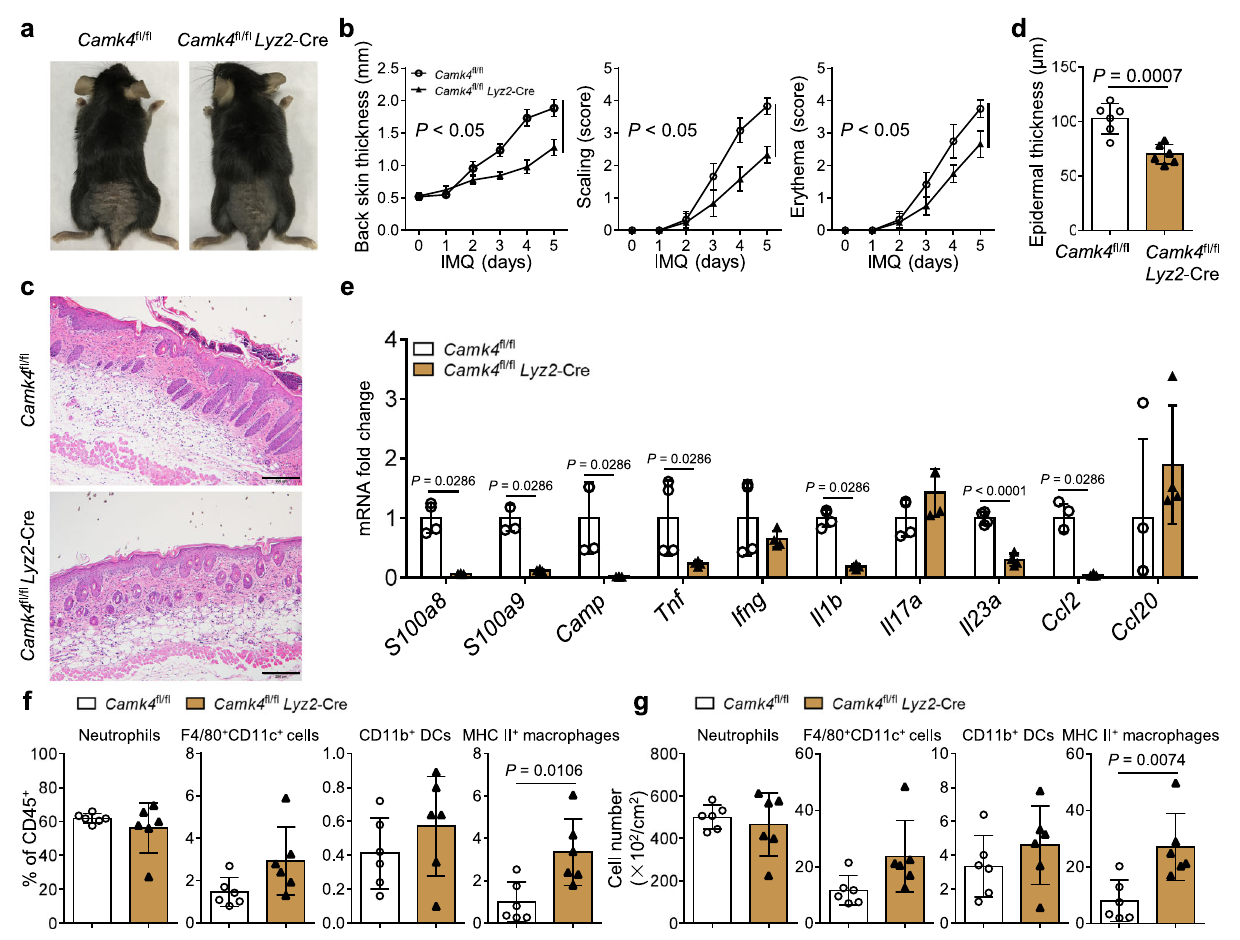
Fig. 7 | Loss of Camk4 in macrophages alleviates IMQ-induced psoriatic in fl ammation. a Representative photos of mouse back skin. b Scoring curves of back skin thickness, scaling, and erythema. c H&E staining of skin sections. Scale bar=200 μ m. d Statistical analysis of epidermal thickness. e Quantitative PCR analysis of pathogenic factors in the skin of IMQ-treated mice ( n =4 biologically independent samples). f , g The percentages and numbers of neutrophils,